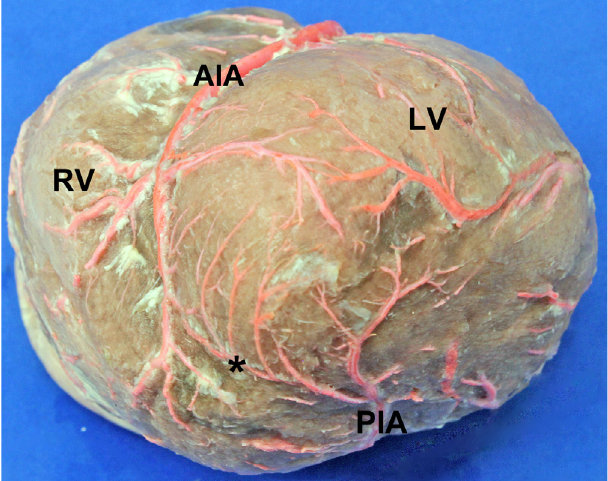
Fig. 2 - Anastomosis between branches of the anterior and posterior interventricular arteries. LV: Left Ventricle. RV: Right Ventricle. AIA: Anterior Interventricular Artery. PIA: Posterior Interventricular Artery. (*): Anastomosis near the apex of the heart